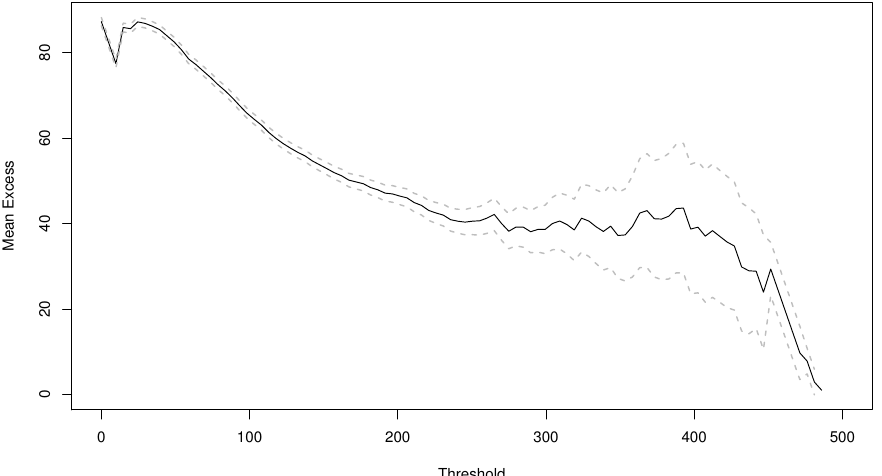
Figure 5. Mean residual life plot and there is an approximately linear relationship exists in the interval [250, 300]. The solid line indicates the mean excess for threshold and the dashed lines indicate 95% CIs of the mean